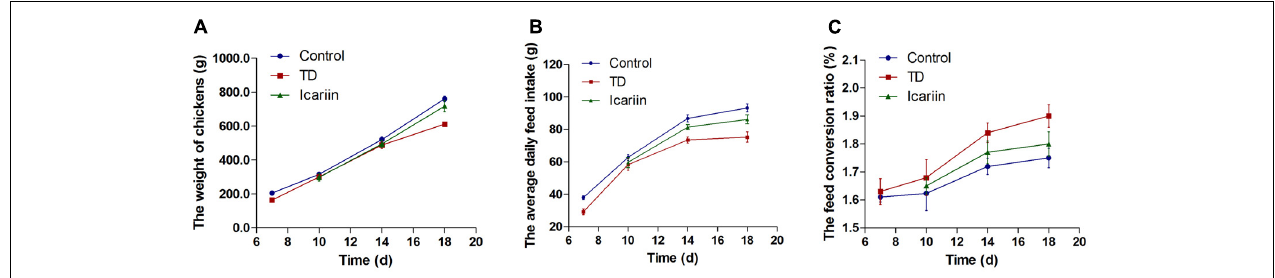
FIGURE 3 | Overall performance parameters analysis of chicken among three groups. (A–C) Correlation analysis among weight of chickens, average daily feed intake, and feed conversion ratio (FCR) were recorded with Pearson test. Overall, the body weight and average daily feed intake in icariin group were increased as compared with TD group, especially after day 10. At the same time, the FCR had a lower value as compared with TD group. Icariin group approach to control group compared with TD group. The standard value of FCR is 1.6 in this